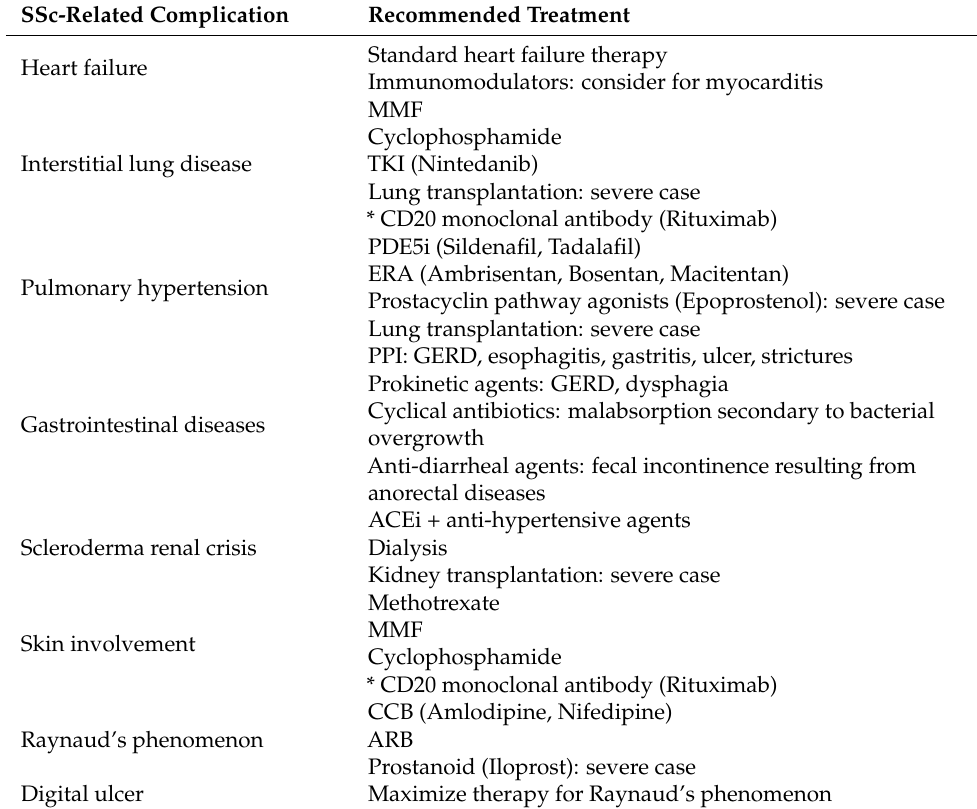
Table 2. Summary of general management for systemic